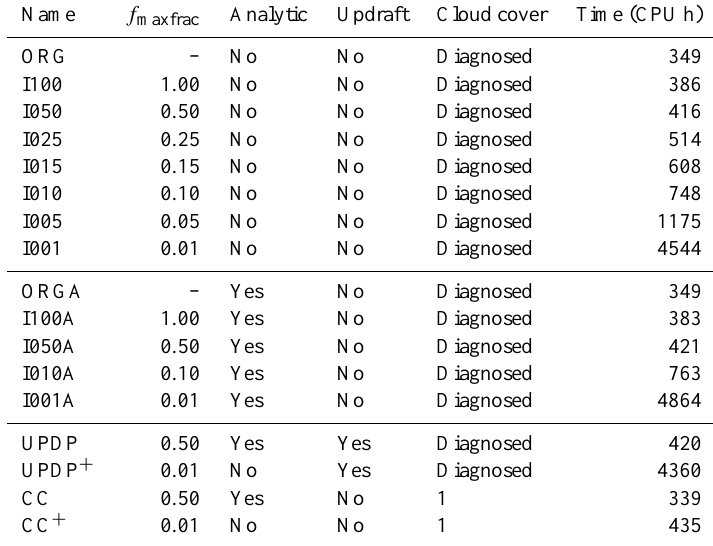
Table 2. Description of the different numerical experiments. Listed are the differences in settings between the simulations and required computational time (in CPU hours). If f maxfrac is set to –, intermediate time steps are not enabled. The columns Analytic and Updraft denote respectively whether the analytic expression and the updated concentrations at the updraft base are applied. The applied cloud cover is either diagnosed in the CONVECT module or set to